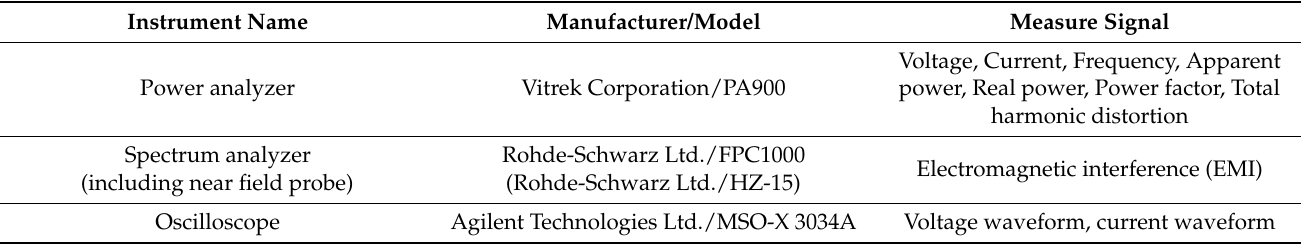
Table 7. Experimental equipment and measurements